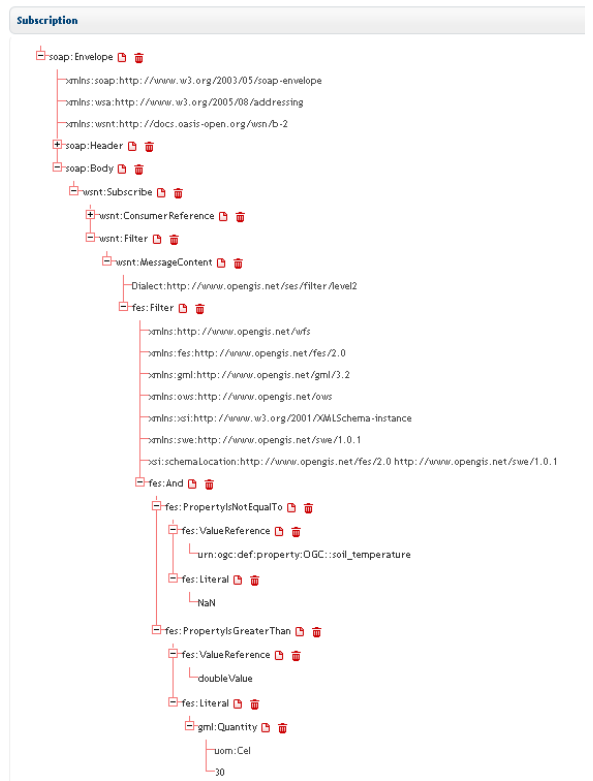
Figure 9. Example for a subscription document in a tree representation.